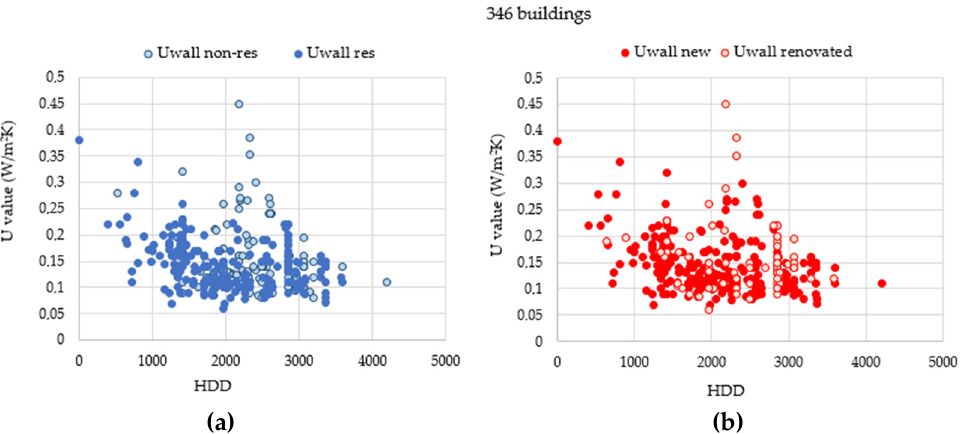
Figure 6. ( a ) Thermal transmittances of walls of nZEB according to HDD, and in relation to the use of the buildings (residential and non ‐ residential); ( b ) type of intervention (new and renovated buildings).